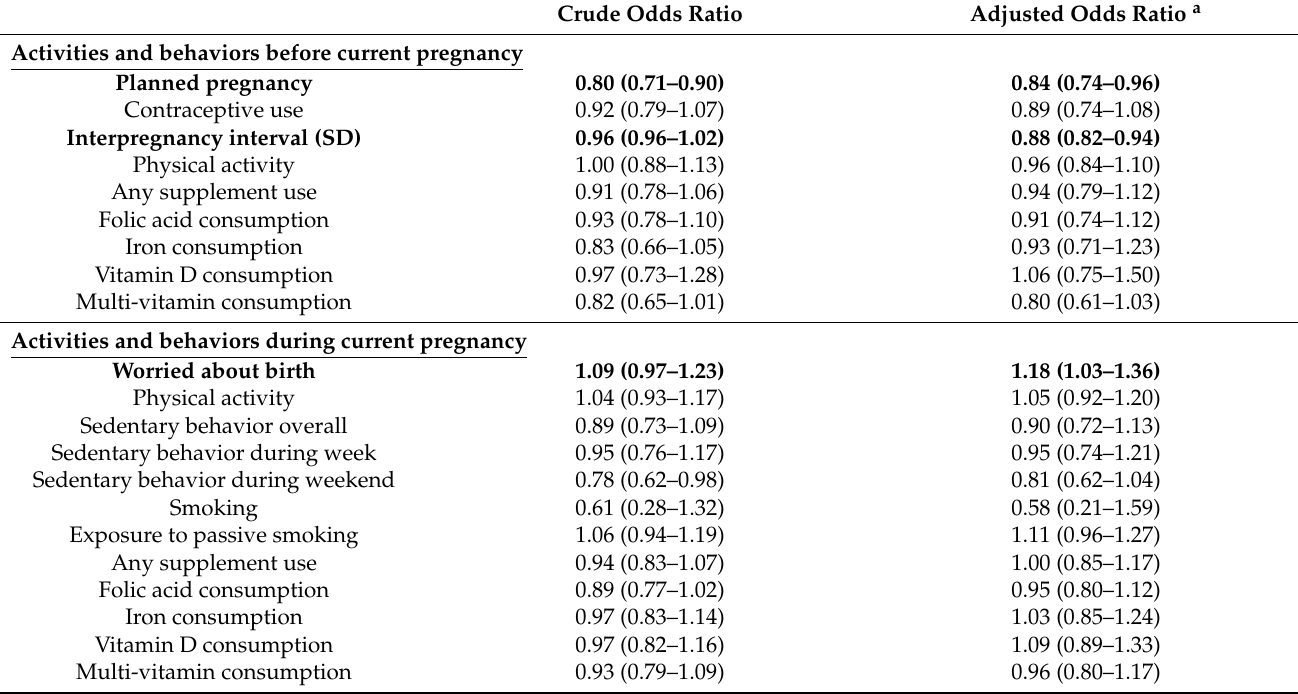
Table 3. Associations between history of previous GDM and activities and behaviors before and during the current pregnancy amongst 5738 pregnant women in Al Ain, UAE. The Mutaba’ah